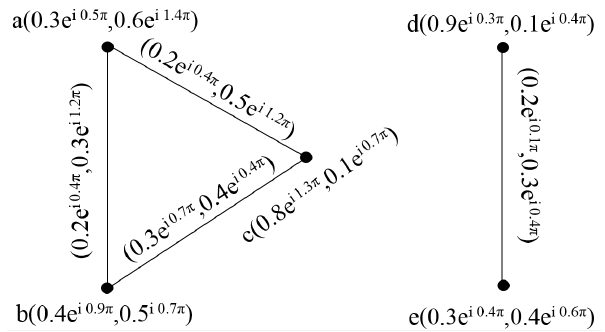
Figure 9. Complex intuitionistic fuzzy graphs of G 1 and G 2 .